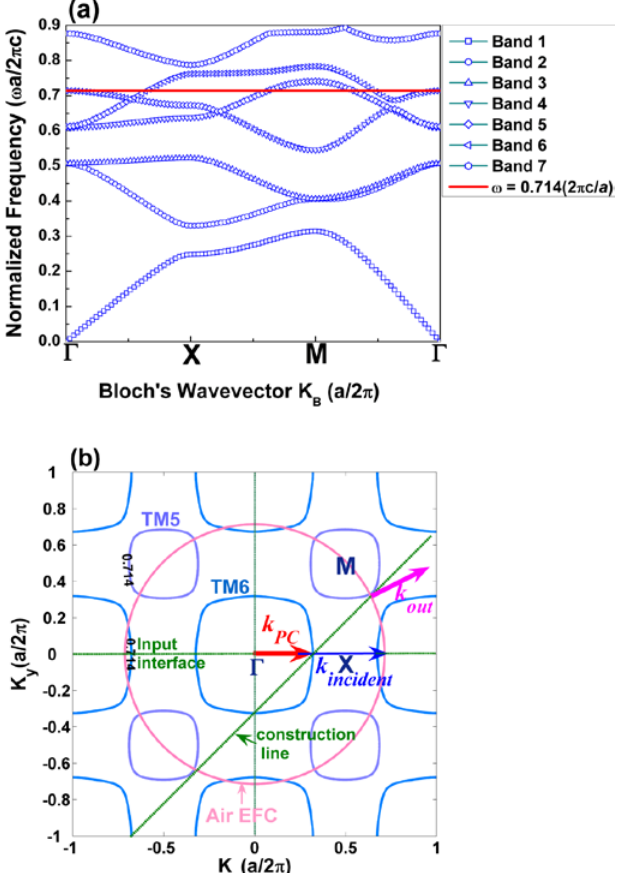
Figure 2: ( a) TM mode b and s tructure o f a s quare l attice glass PC. Operating frequency 0.714(2πc/ a ) i s i ndicated with t he s olid h orizontal l ine i n t he plot . (a) W